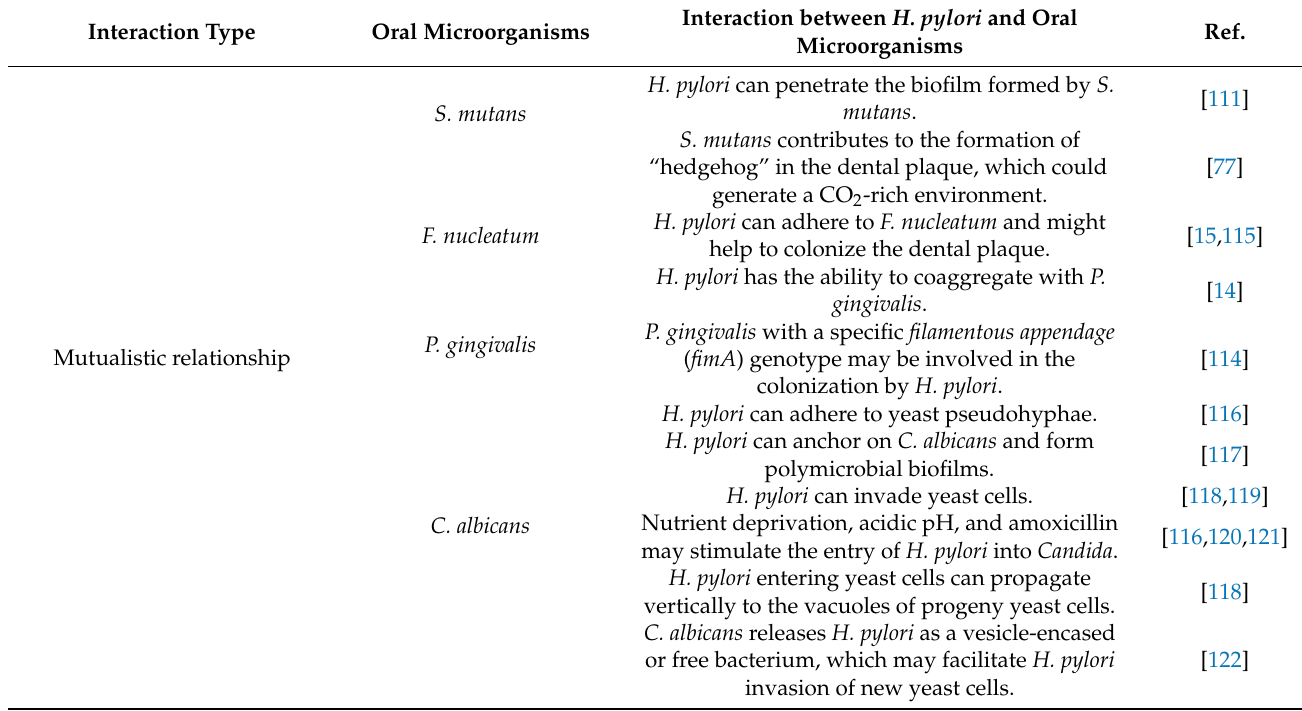
Table 3. Interaction between H. pylori and oral microorganisms. Interaction